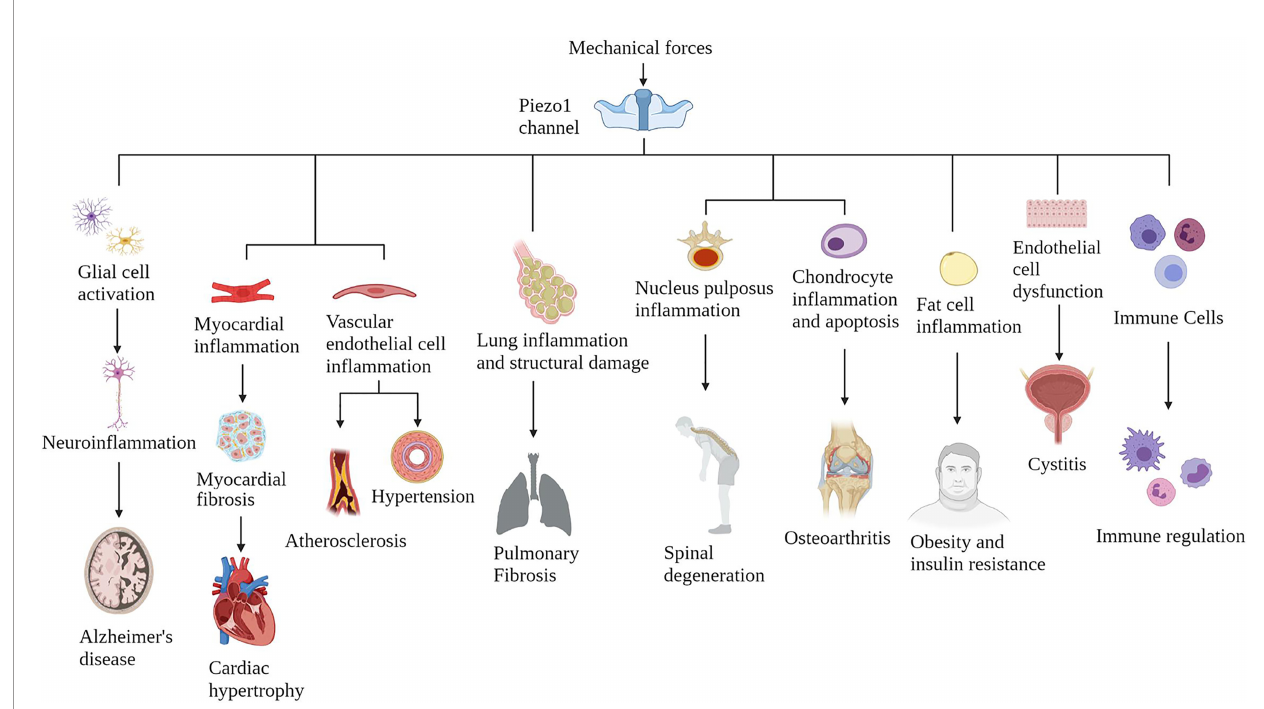
FIGURE 3 | The Piezo1 channel responds to various mechanical force activation and induces chronic in fl ammatory diseases in multiple systems. The Piezo1 channel transduces mechanical stimulation into an intracellular signal cascade, leading to tissue damage and in fl